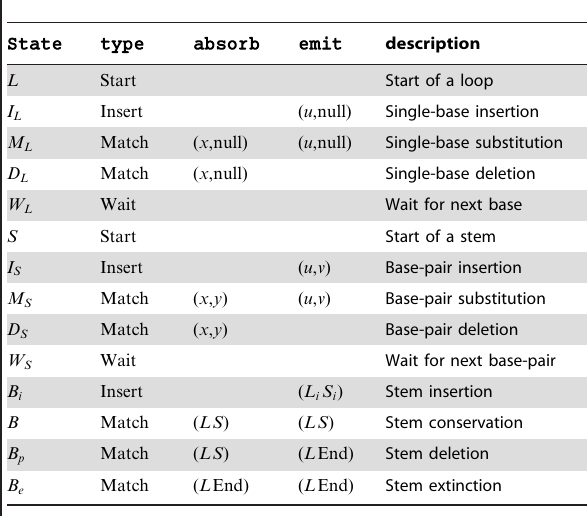
Table 1. State types of the singlet transducer (single- sequence SCFG) of the TKF Structure Tree model.